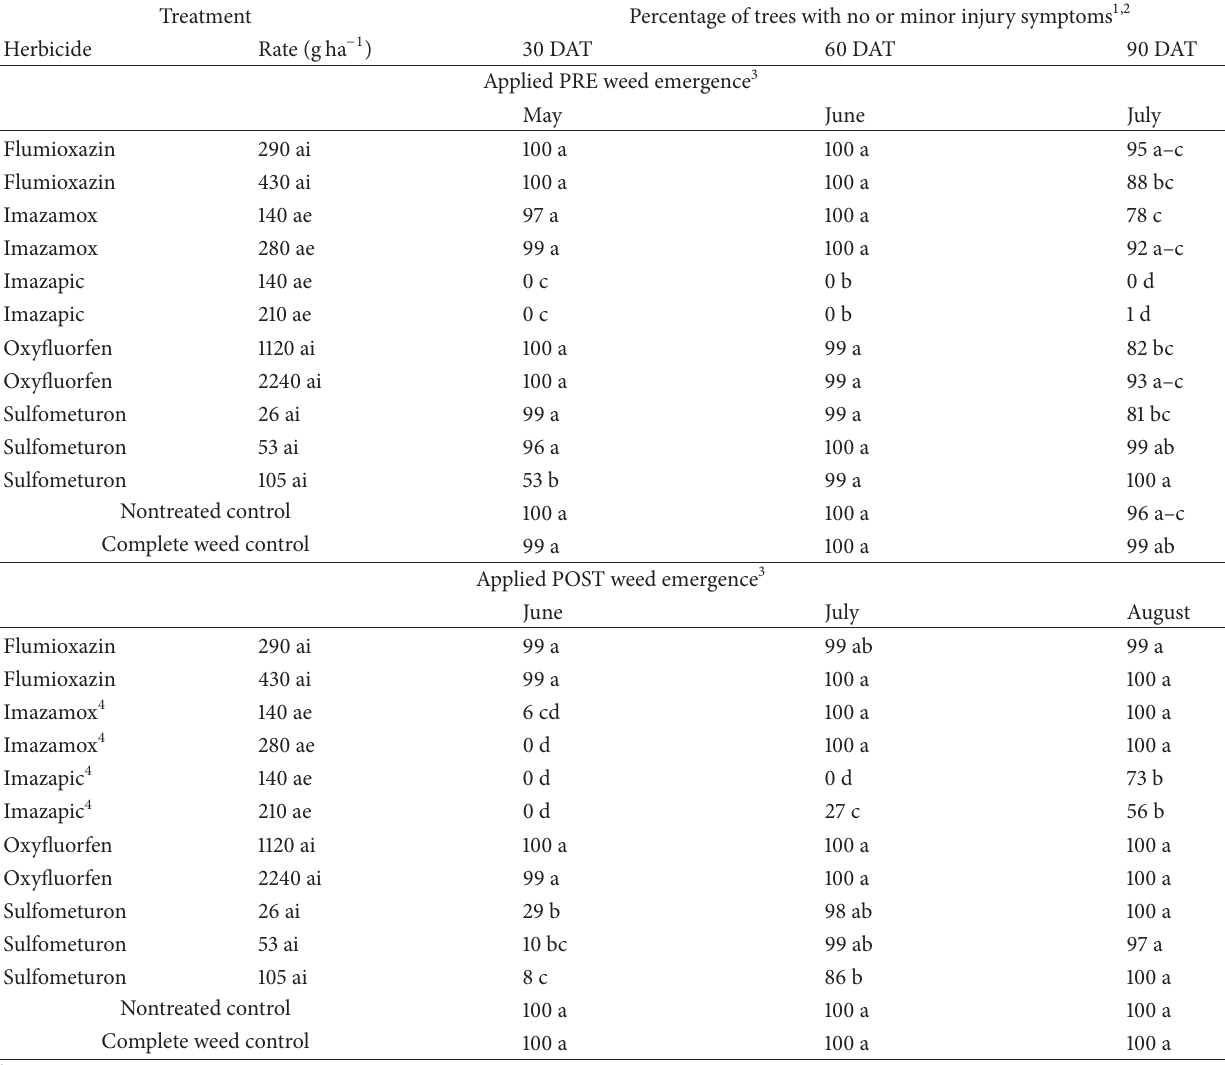
Table 5: Percentage of Eucalyptus urograndis trees with no or minor injury symptoms at 30, 60, and 90 days after treatment (DAT) for herbicides applied over newly planted rooted cuttings either prior to weed emergence (PRE) or after weed emergence (POST). Treatments were evaluated at the end of the month indicated for each application timing and periodic